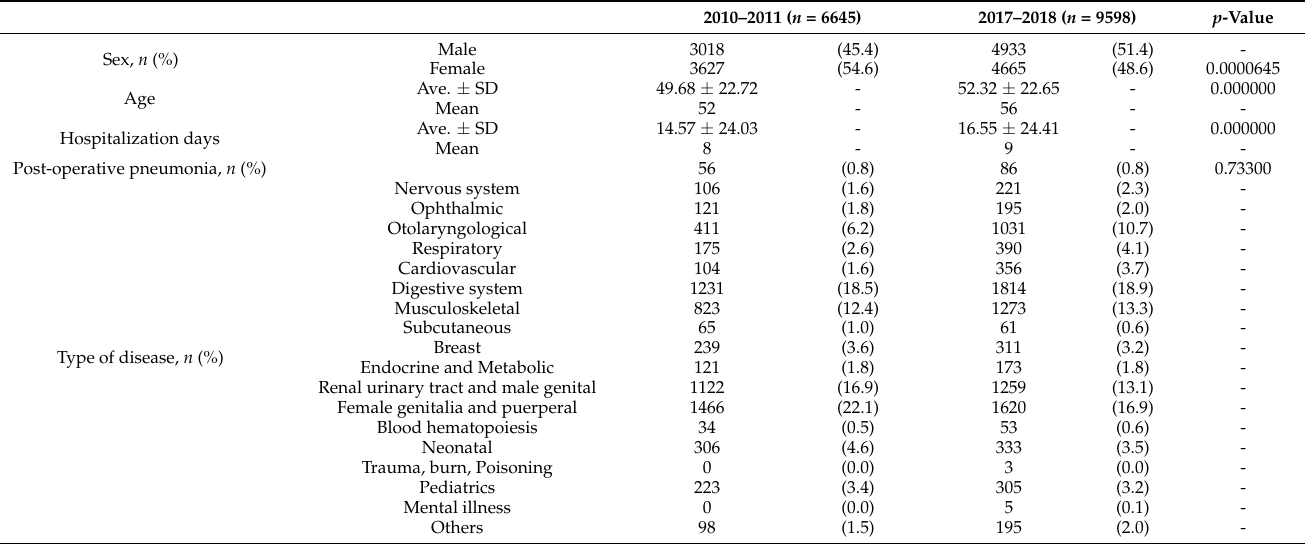
Table 2. Characteristics of the sample